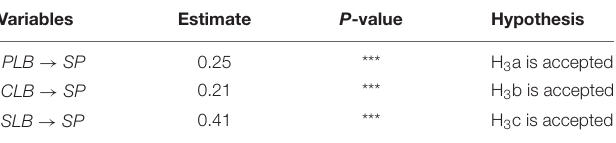
TABLE 8 | Dimensional analysis of learning behavior (LB) with SP.